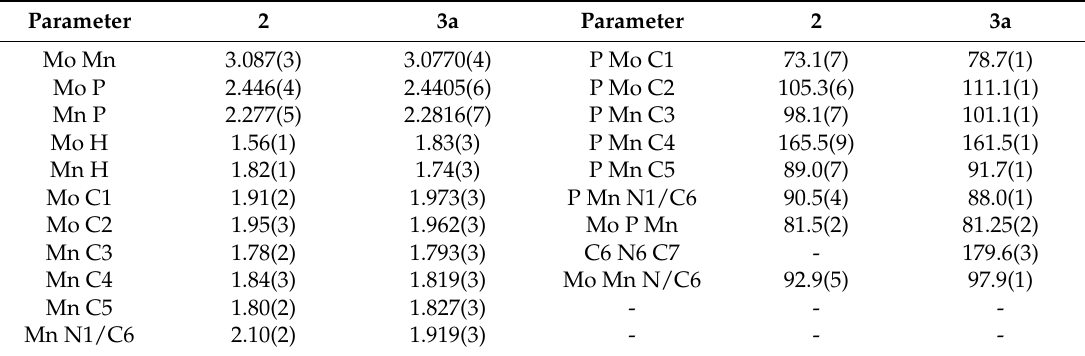
Figure 2. ORTEP drawing (30% probability) of compounds 2 (left) and 3a (right), with aryl rings (except their C 1 atoms) and most H atoms omitted. Table 1. Selected Bond distances (Å ) and Angles ( o ) for Compounds 2 and 3a .